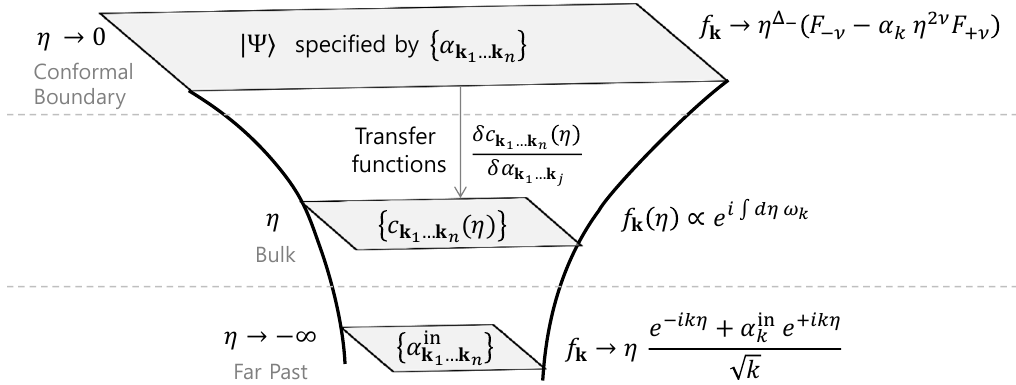
Figure 1 . A cartoon of the expanding de Sitter spacetime. We refer to late times, η → 0 , as the conformal boundary, and denote the wavefunction coefficients there by α n . This boundary condition can be translated into a bulk wavefunction, with coefficients c n ( η ) , by means of various “transfer functions” I ν 1 ...ν n ( η ) which we define in section 4 — these objects are analytic (for any k 1 ... k n local Hamiltonian) until horizon crossing at | kη | ∼ 1 where they develop non-analyticities (such as the 1 /k T pole). In the far past, η → −∞ , we denote the wavefunction coefficients as α in . Imposing n the Bunch-Davies vacuum state in the far past corresponds simply to α in = 0 n